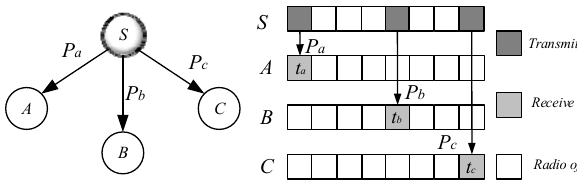
Figure 1. code dissemination method in loss and low duty cycle-based WSNS. Figure 1. Code dissemination method in loss and low duty cycle-based